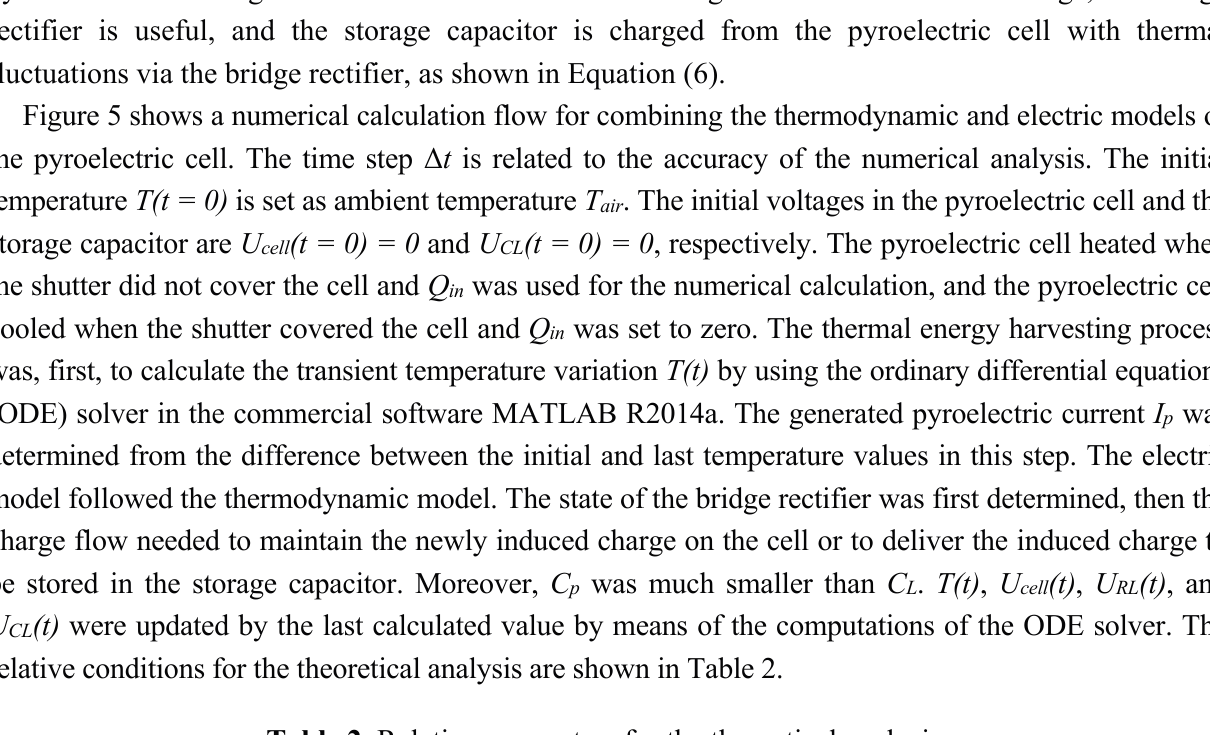
Table 2. Relative parameters for the theoretical